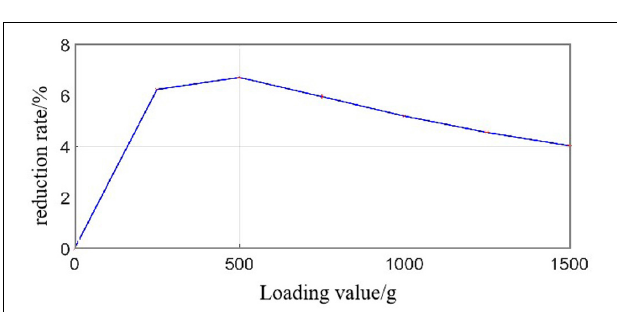
FIGURE 14 | The location error reduction rate of second-stage fusion relative to the first-stage fusion.